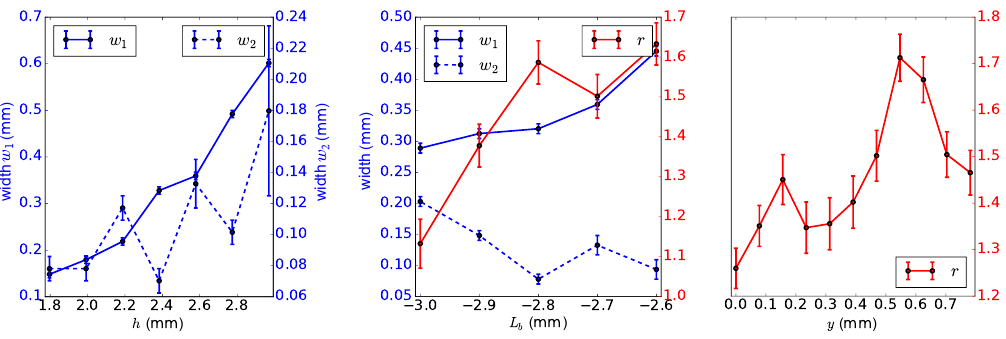
Figure 19. Ramp characterization with respect to different parameters. Left : Widths w 1 and w 2 versus height h . Middl e: Widths w 1 , w 2 and ratio r verus position of the blade L b . Right : Ratio r along y